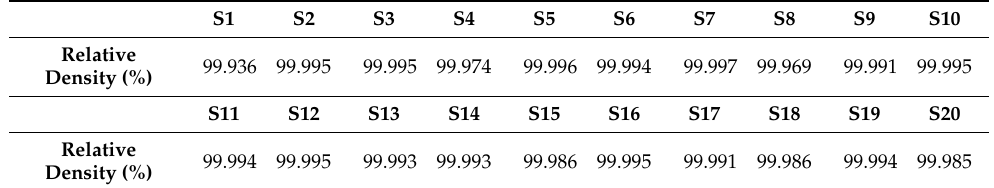
Table 5. Relative density % of cubic samples of FeSi3 steel. The density taken as the reference was 7.68 gcm − 3.